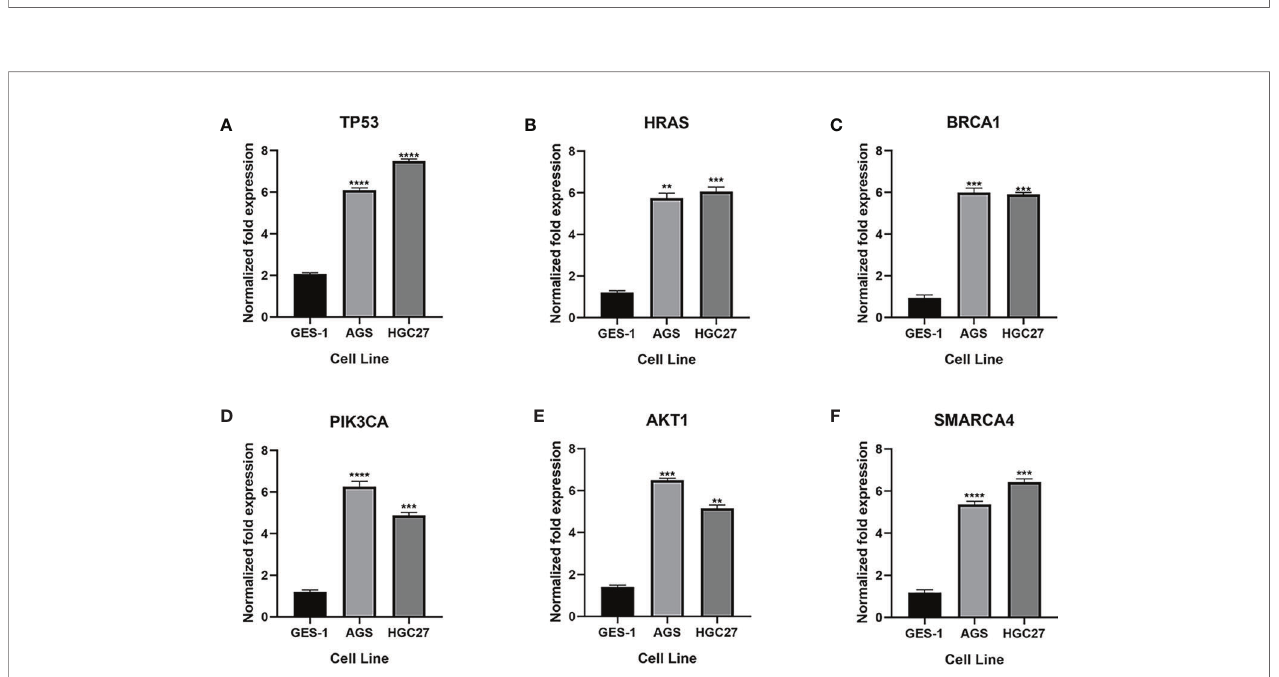
FIGURE 10 | Expression of the key genes in gastric cancer cells. (A-F) qRT-PCR analysis of mRNA expression of key genes in GES-1, MGC803 and AGS cells. **P < 0.01, ***P < 0.001, and ****P <